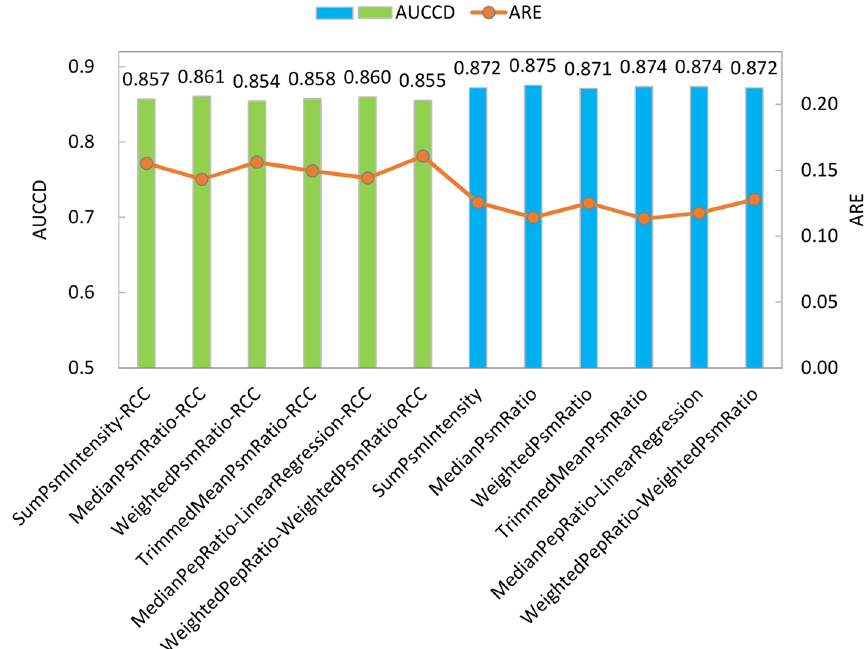
Figure 3. Area under the curve of coverage vs deviation (AUCCD, primary y-axis) and average relative error (ARE, secondary y-axis) of the 12 algorithmic combinations for NCI-7. The green and blue bars correspond to methods with RCC enabled and disabled,